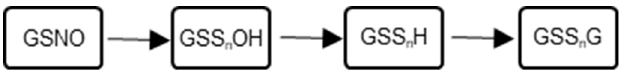
Figure 9. Relative distributions ( A ) and natural logarithm of relative distributions ( B ) of DH trapped GSS n D, acetamide trapped GSS n A, and oxidized GSS n G species determined from reactions of GSNO (1 mM) with Na 2 S (1 mM): (Squares) in the presence of DH (50 mM) and IA (50 mM); (triangles) in the presence of IA only; (circles) in the absence of DH and IA in iP buffer at pH